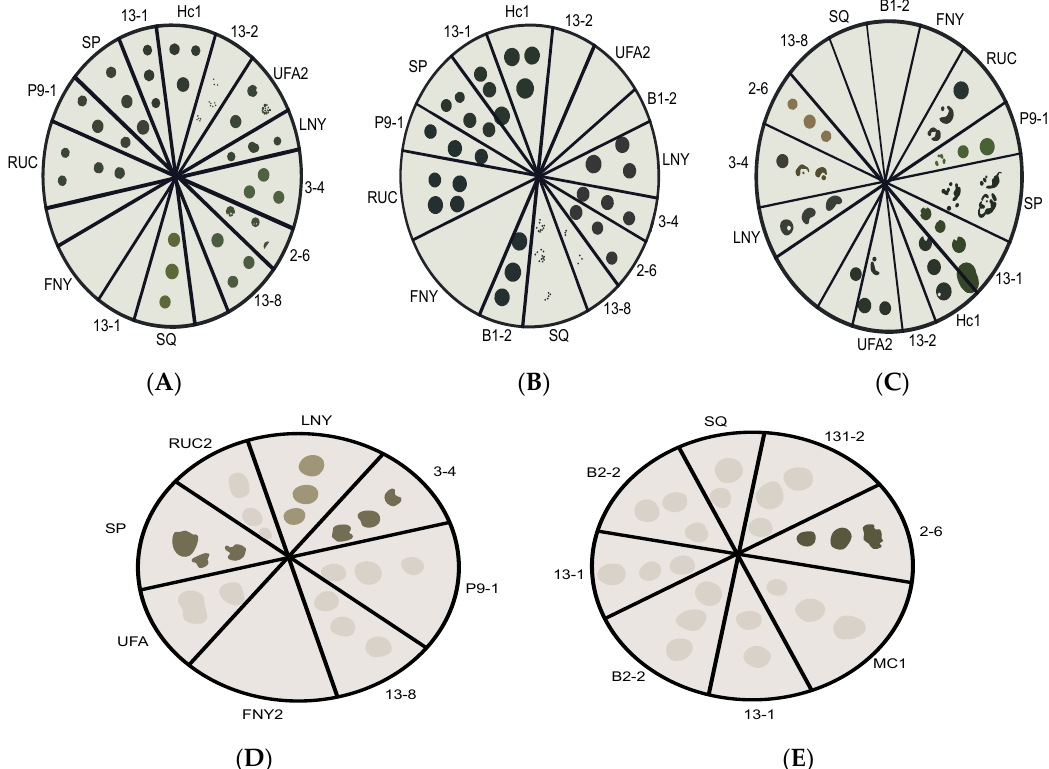
Figure 1. Vectorized plates from screening of auto-, mixo- and hetero-trophic growth of 14 algal strains isolated in Sweden. The strains are designated 2-6 ( Desmodesmium sp.), 3-4 ( Coelastrella sp.), 13-1 ( Chlorella vulgaris ), 13-2 ( Chlorella vulgaris ), 13-8 ( Scenedesmus obliquus) , SP ( Scenedesmus obliquus ), B1-2 ( Monorapidium sp.), UFA-2 ( Scotiollopsis reticulata ), LNY ( Chlorella vulgaris ), RUC-2 ( Desmodesmus sp.), FNY-2 ( Ettilia pseduoalveolaris ), SQ2 ( Desmodesmus opoliensis ), MC1 ( Chlamydomonas debaryana ), P9-1 ( Micratinium sp.). Schematic diagram showing growth of colonies of the strains on agar plates under: ( A ) autotrophic conditions, with 16 h light (100 µ mL m − 2 s − 1 ) / 8 h dark cycles: ( B ) mixotrophic conditions with the mentioned light / dark cycles and 3 g / L glucose as a carbon source, ( C ) heterotrophic conditions with 3 g / L glucose as carbon source and ( D ) and ( E ) heterotrophic conditions with 2 g / L glycerol.